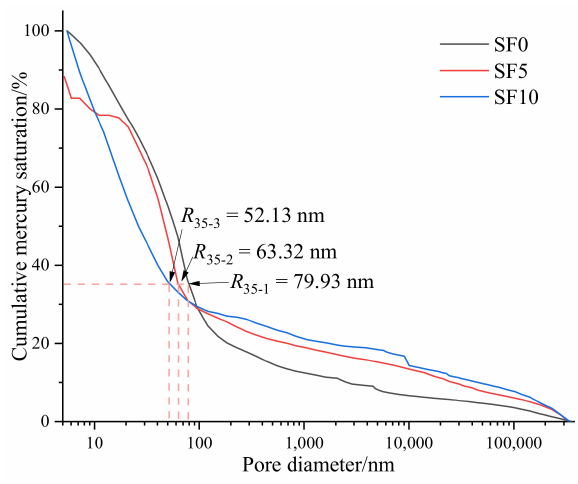
Figure 8. Cumulative mercury saturation versus the pore